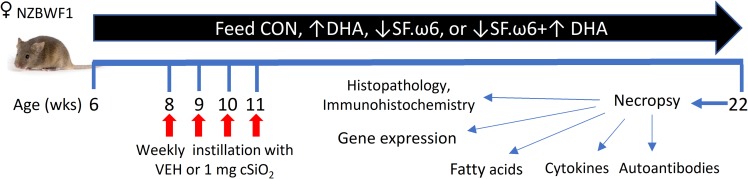
Experimental design.Feeding of experimental diets was begun in 6 wk old female NZBWF1 mice. At 8 wk of age, mice were intranasally instilled with cSiO2 once per wk for 4 wk. Body weights were measured weekly, and urine was collected weekly from 18 wk of age onward to monitor the development of proteinuria. Animals were necropsied at 22 wk of age, 11 wk following the final cSiO2 instillation. Plasma, BALF, and tissues were collected for analysis.